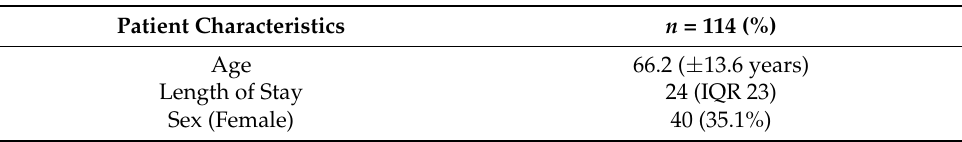
Table 1. Clinical characteristics of 114 patients who suffered from at least one HAI in our study